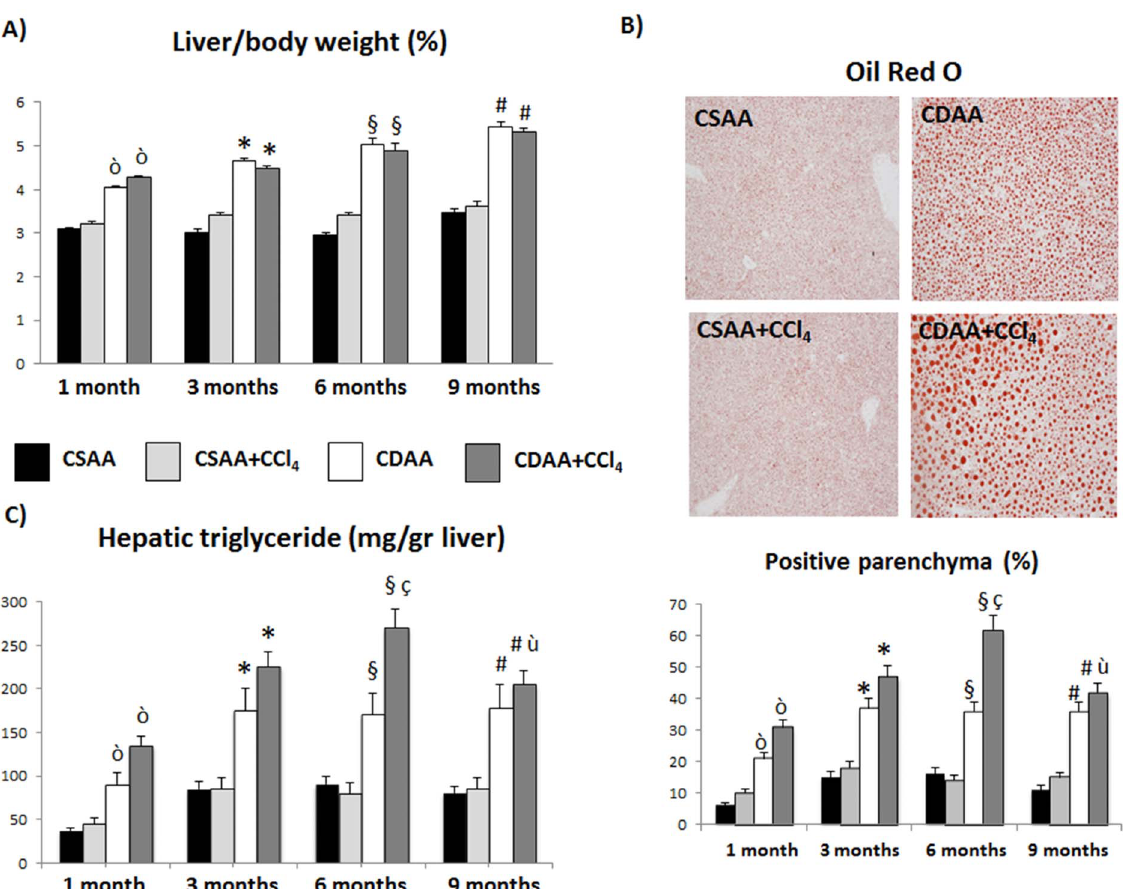
Figure 2. Treatment with CDAA determines a progressive increase of hepatic steatosis. A) Increased levels of liver/body weight fraction are observed in the group of mice treated with CDAA diet, either with or without CCl 4 administration, in comparison to mice treated with control diet, starting at 1 month. B) Histochemical staining and relative morphometric evaluation for Oil Red O and C) hepatic triglyceride measurement show increased deposition of lipids in the liver parenchyma of CDAA and CDAA + CCl 4 treated animals in comparison to CSAA treated mice. Data represent mean 6 SD; o` p , 0.05 vs CSAA 1 month; *p , 0.05 vs CSAA 3 months; 1 p , 0.05 vs CSAA 6 months; # p , 0.05 vs CSAA 9 months; c¸ p , 0.05 vs CDAA 6 months; u` p , 0.05 vs CDAA 9